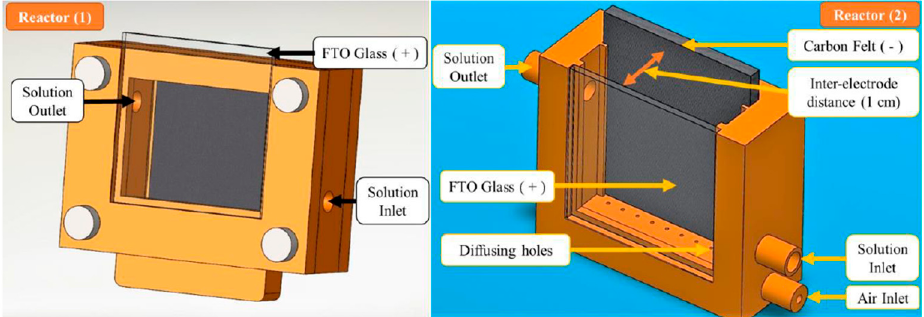
Figure 14. Reactor (1) air bubbled in a separate tank, Reactor (2) air bubbled directly into reactor. (Reproduced with permission from [68]: Mousset, E.; Huang Weiqi, V.; Foong Yang Kai, B.; Koh, J.S.; Tng, J.W.; Wang, Z.; Lefebvre, O. A new 3D-printed photoelectrocatalytic reactor combining the benefits of a transparent electrode and the Fenton reaction for advanced wastewater treatment. J. Mater. Chem. A 2017 , 5 , 24951–24964, doi:10.1039/c7ta08182k. Copyright (2017), Royal Society of Chemistry Publishing (Cambridge,